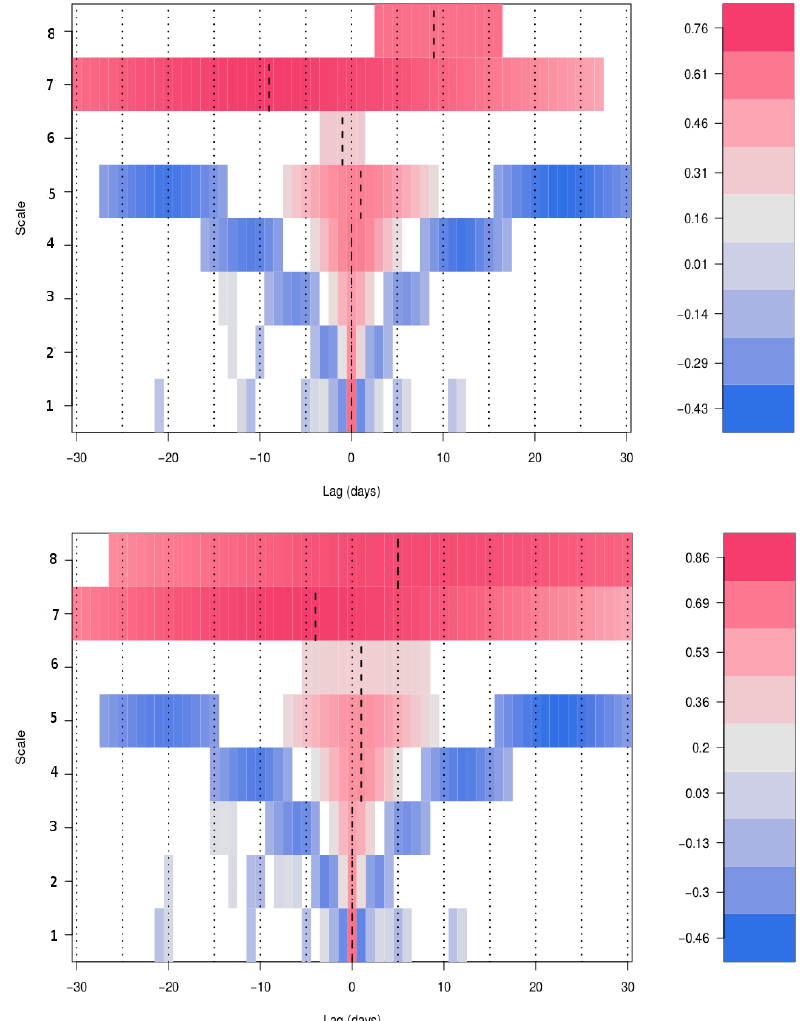
Figure 5. Wavelet cross-correlation for the long-term futures prices estimated by a stochastic model and spot prices ( top ) and futures prices obtained as the longest maturity on that day and spot prices ( bottom ).